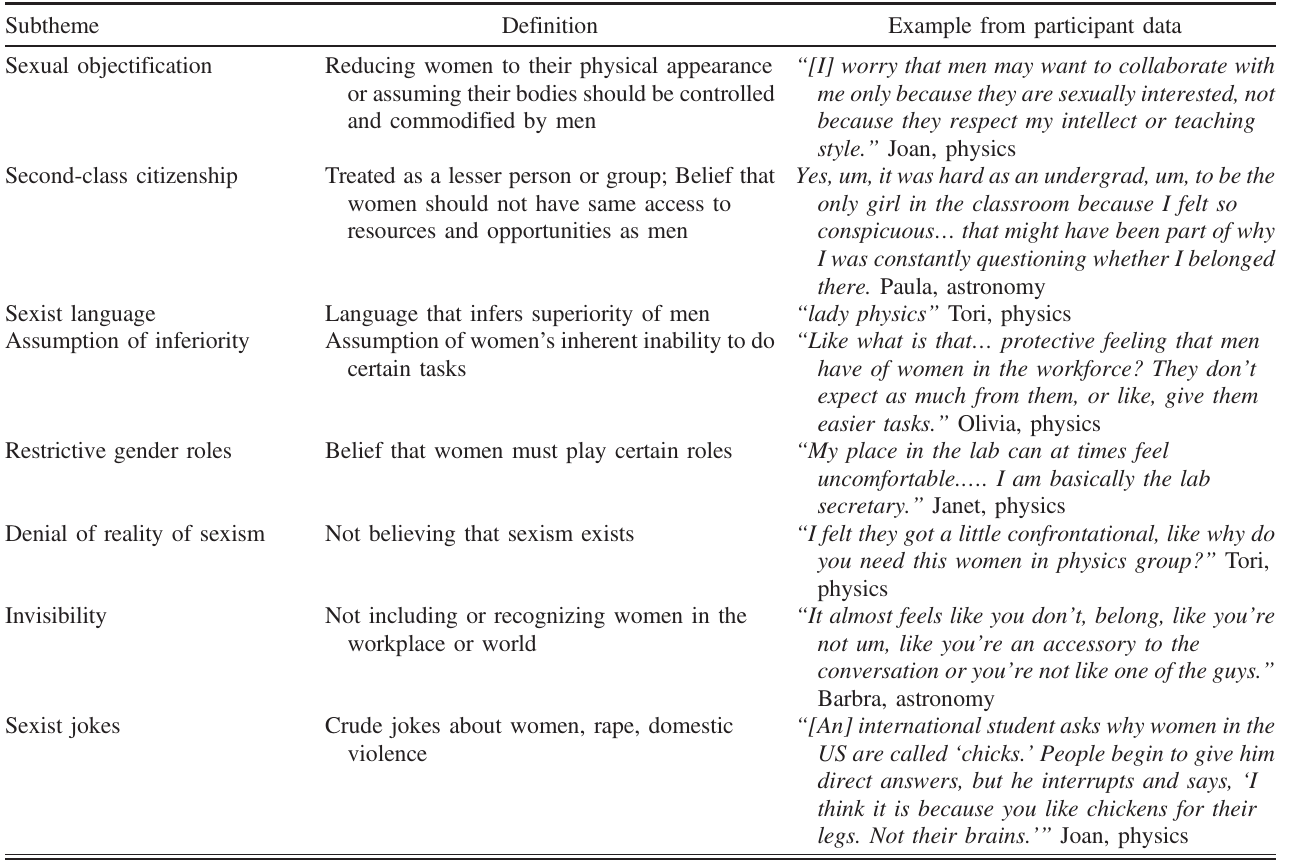
TABLE II. Gendered subthemes for microaggressions N ¼ 16 = 21